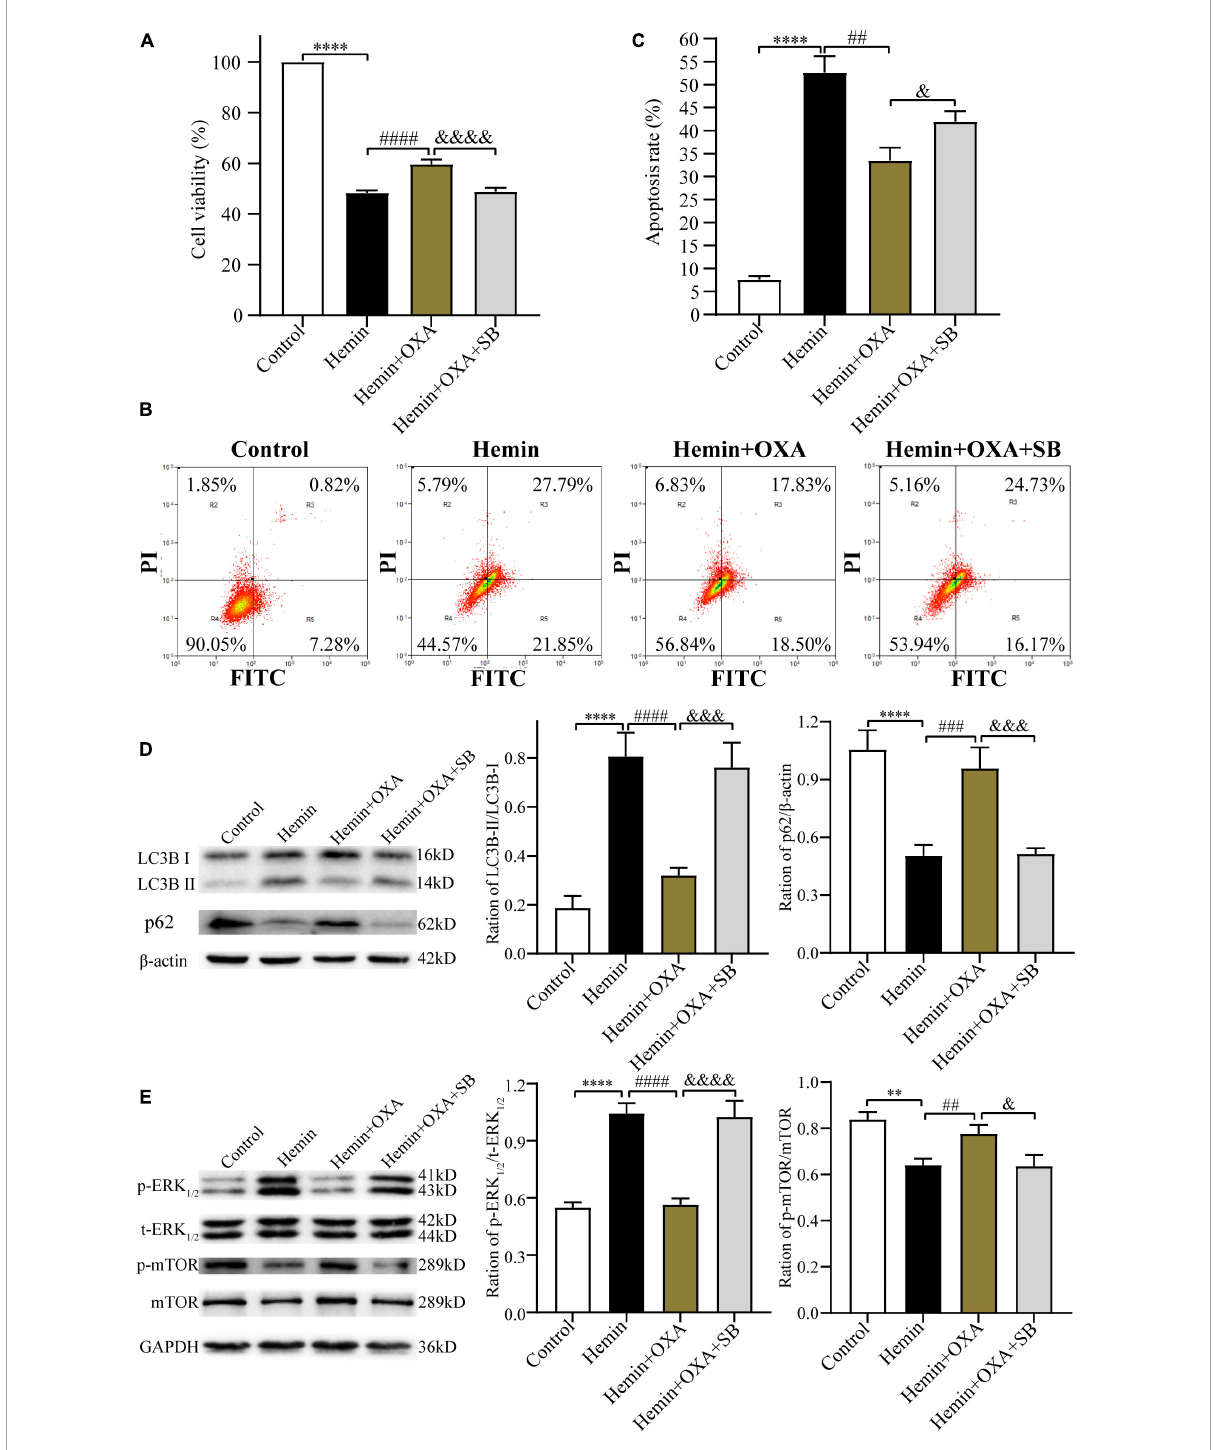
FIGURE8 The protective effect of OXA needs to be combined with OXR1. (A) OXA attenuates the hemin-induced decrease in cell viability, while aggravated it after SB334867 administration. (B) Representative FCM plots of Annexin V-FITC apoptosis detection assay showed that OXR1 inhibitor increased apoptosis rate, and reversed the neuroprotective effect of OXA. (C) Quantified results of the flow cytometric analysis. (D) Western blot images of LC3B and p62 and results of quantitative analysis in each group. (E) Representative western blots of p-mTOR and p-ERK 1 / 2 and results of quantitative analysis in PC12 cells treated with OXA and SB334867. ∗∗ p < 0.01 and ∗∗∗∗ p < 0.0001 vs. the control group; ## p < 0.01, ### p < 0.001 and #### p < 0.0001 vs. the hemin group; & p < 0.05, &&& p < 0.001 and &&&& p < 0.0001 vs. the hemin + OXA